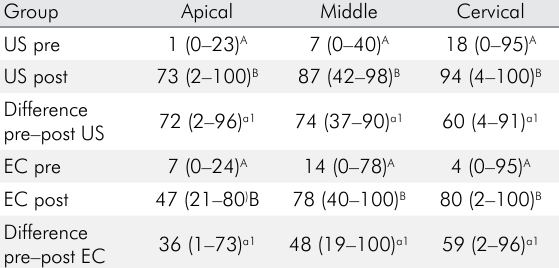
Different superscript capital letters in each column indicate statistical differences in the same group (p < 0.05); Different superscript lowercase letters in each column indicate statistical differences between groups (p < 0.05); Different superscript numbers in each row indicate statistical differences in each row in root canal thirds (p <